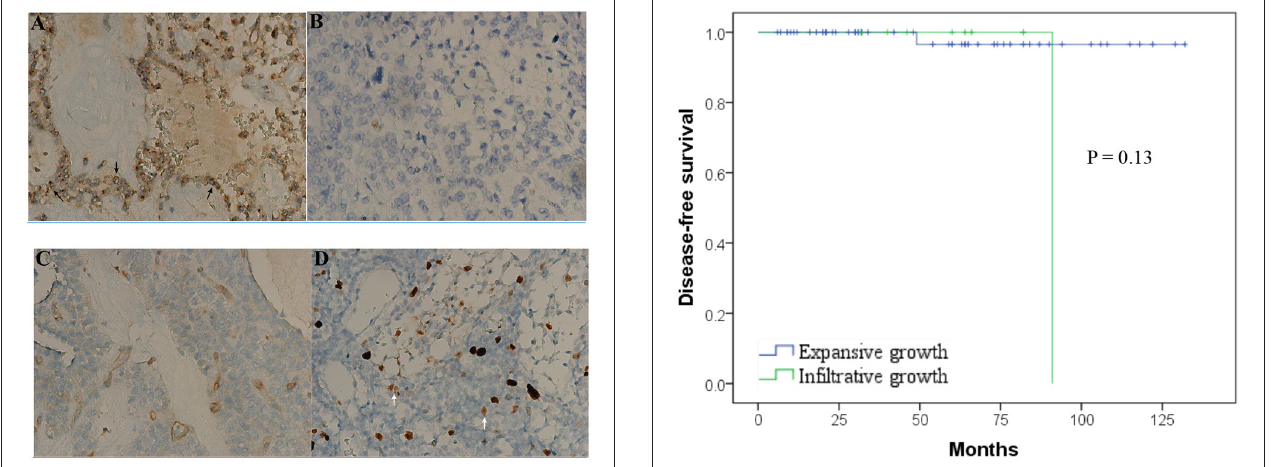
FIGURE 1 | Immunohistochemical findings of CD99 and Ki-67 index in solid-pseudopapillary neoplasms (SPN) after surgery (x200). The tumor appears to have a particular dot-like paranuclei expression of CD99 (black arrow, A ) with low Ki-67 index 1% (B) . The other tumor appearing to be negative for CD99 expression (C) has much high Ki-67 index 10% (white arrow, D ).